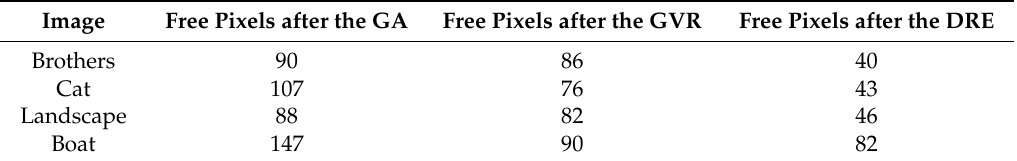
Table 1. Remaining free pixels after each